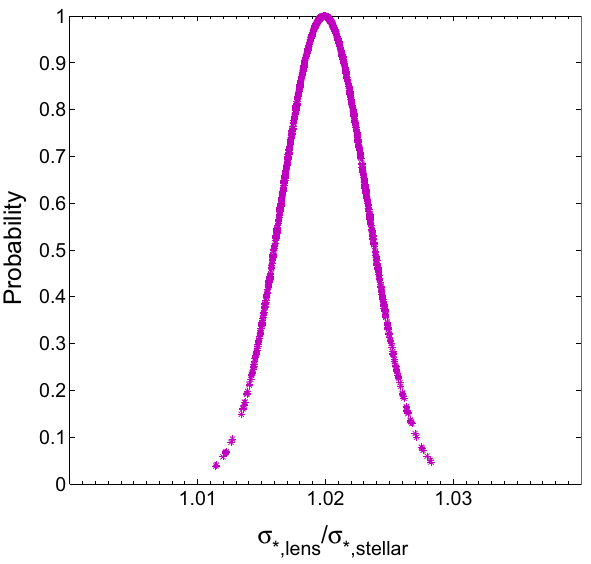
Fig. 9 Constraints on the matter density parameter (in the flat Λ CDM model) from the current SGL systems, with different luminosity density profiles for the lensing galaxies ( ∝ r − δ